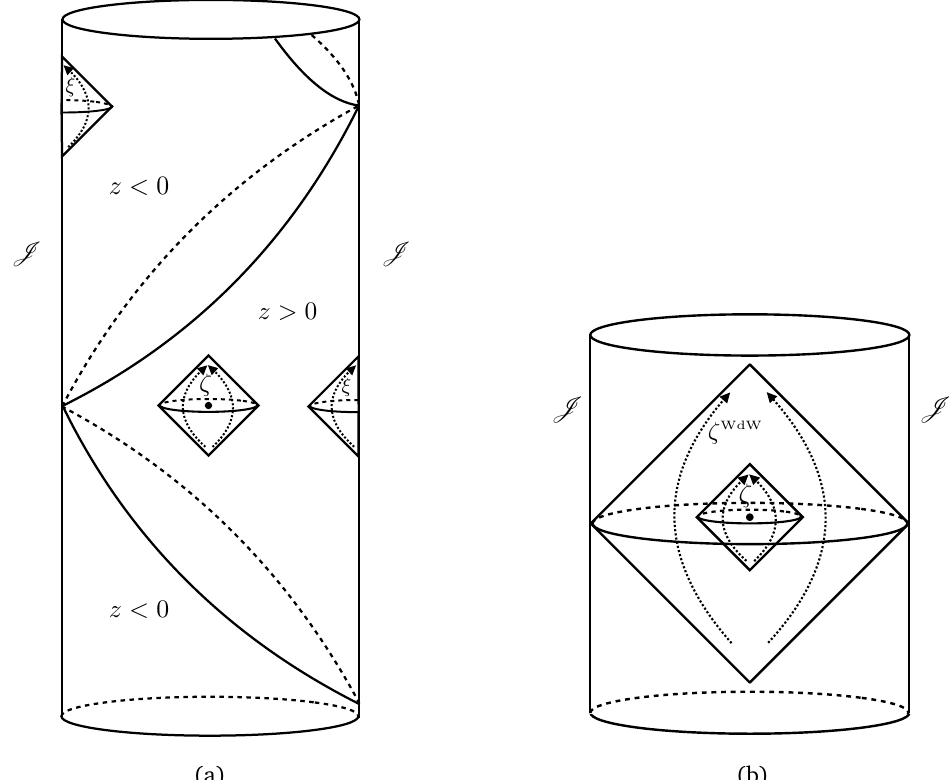
Figure 6: (a) A causal diamond centered at the origin of AdS space can be mapped to two equally large AdS-Rindler wedges in two different Poincaré patches. The situation is depicted (cid:112) 3 of the centered ball, since for larger values R > L / for a coordinate radius R < L / diamond overlaps with the right Rindler wedge. (b) A small causal diamond and infinite size diamond in AdS space. The infinite size diamond is called the Wheeler-DeWitt patch of global AdS, and is also preserved by a conformal Killing